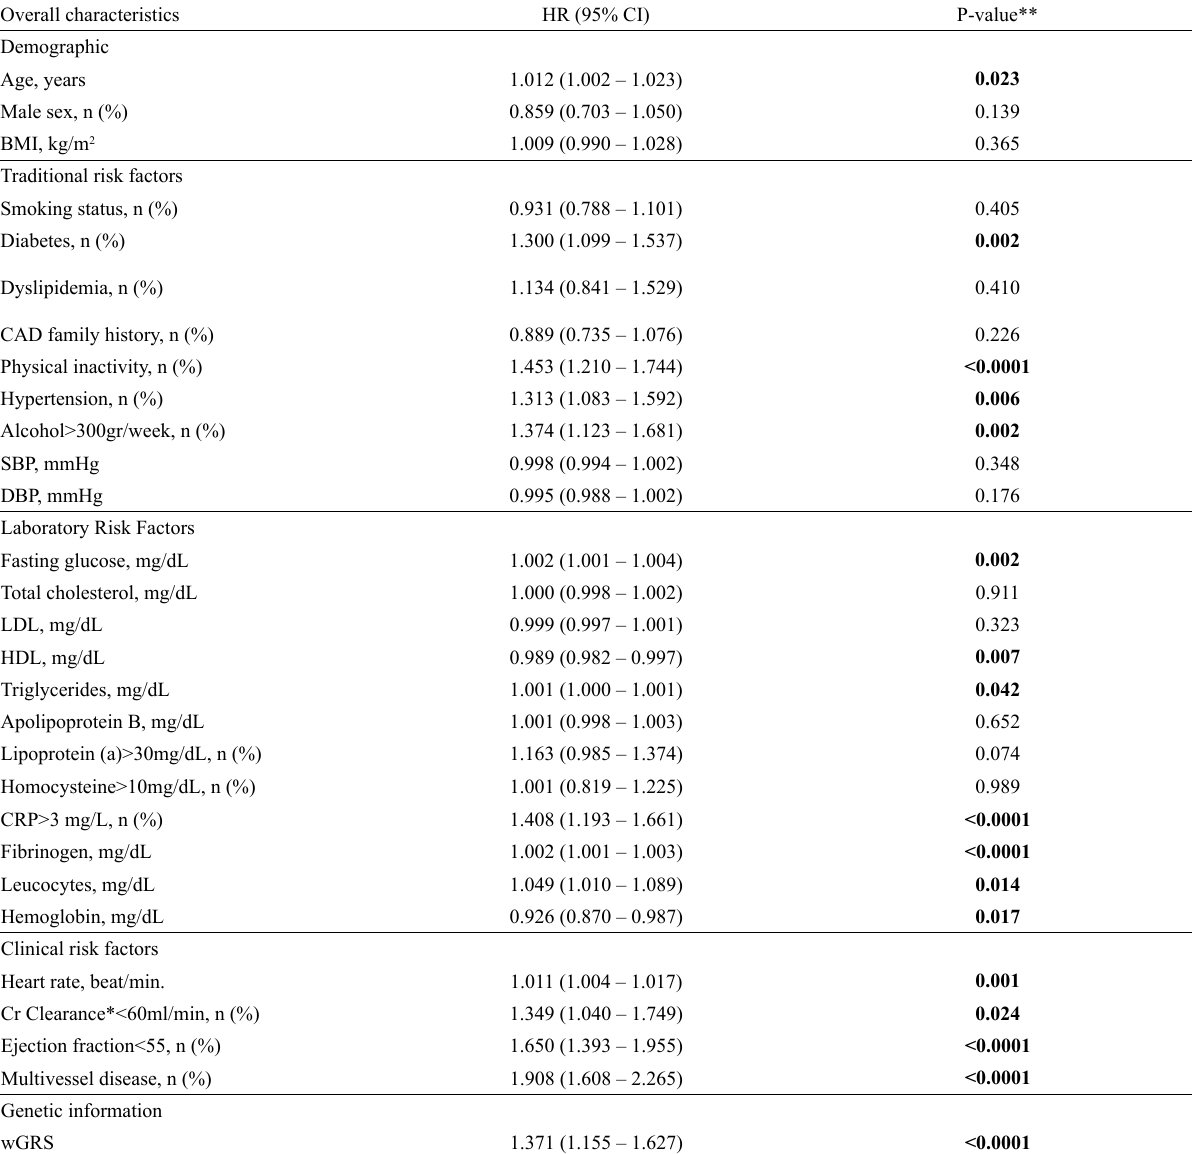
Table 3 ‒ Individual MACE risk (HR) of all studied variables.